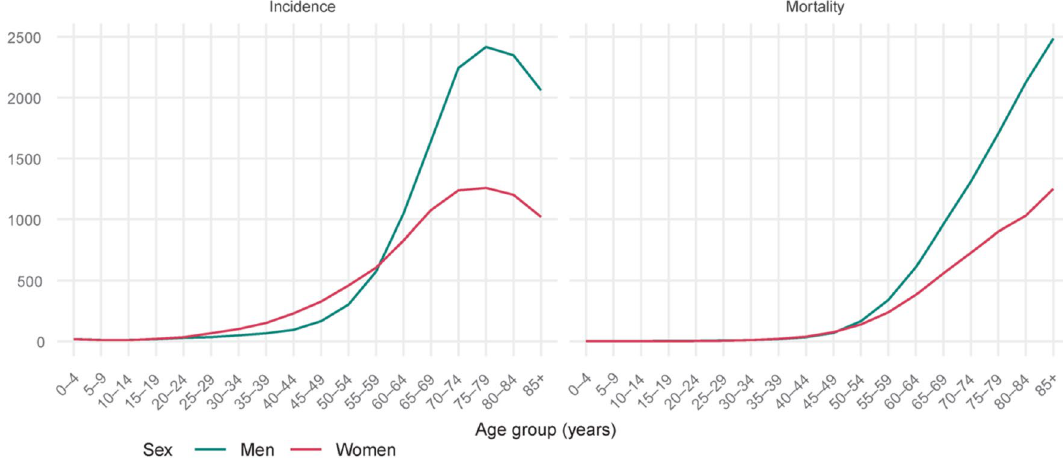
Figure 6. Cancer incidence and mortality rates per 100,000, by age group—Poland, 2019.